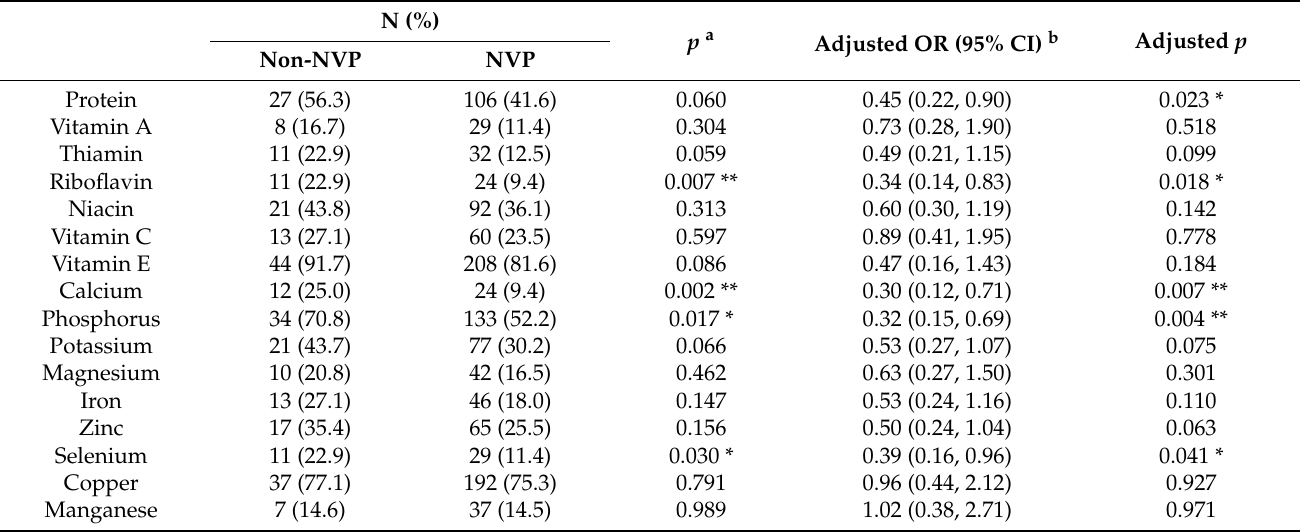
Table 4. Comparison of dietary nutrients’ adequacy rate between pregnant women with and without nausea and vomiting in early